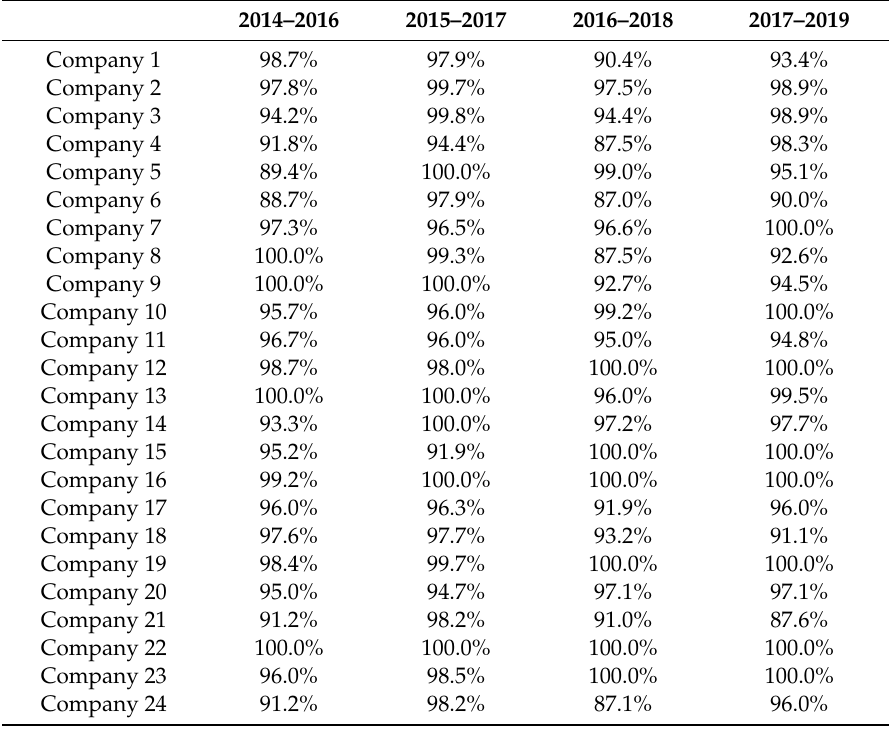
Table 6. Average of windows in FDH model for each three years.